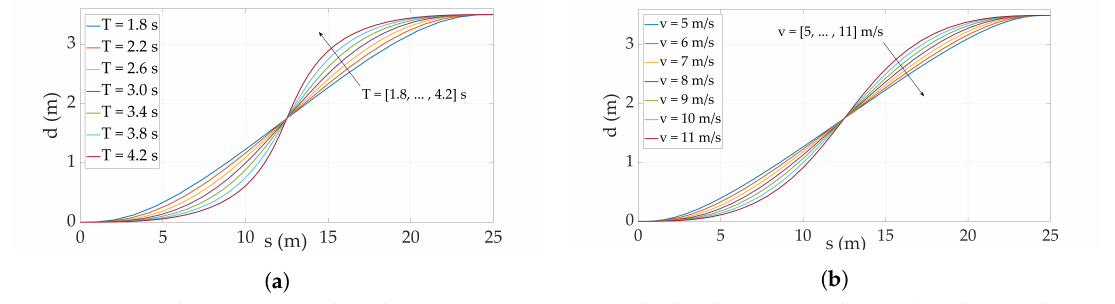
Figure 5. Jerk minimization based-trajectory generation on the local Frenet coordinate. ( a ) Solving jerk minimization using a matrix form for a different traveling time T ; ( b ) Solving jerk minimization using a matrix form for a different velocity v